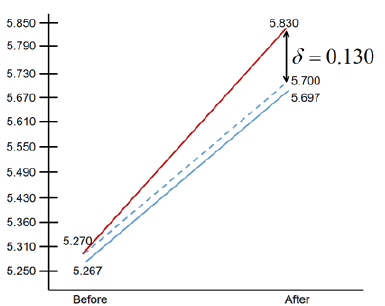
Blue line: control group, Red line: experimental group, Dashed line: experimental group’s original tendency Figure 4. Difference-in-differences estimation results: Beginning of luxury housing construction as the differentiation